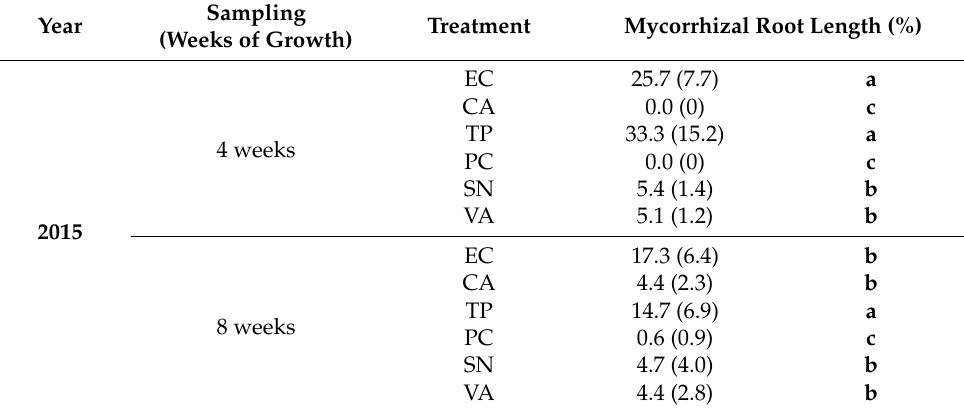
Table 1. Colonization of weed roots with arbuscular mycorrhizal fungi (%) in a pot experiment (6 kg of a P deficient loamy sand per pot) under semi field conditions in 2015 and 2016. Values are expressed as means ± (SD). Lower letters indicate significant differences ( p < 0.05, Kruskal-Wallis test, n = 42). (EC: Echinochloa crus-galli , CA: Chenopodium album , TP: Tripleurospermum perforatum